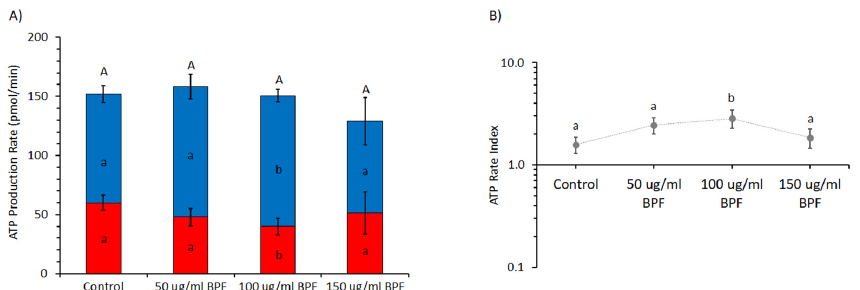
Figure 4. Effect of the BPF on the real-time ATP production rate in pAECs. ( A ) Evaluation of ATP production rate by mitochondrial OXPHOS (blue) ( █ ) or by glycolysis (red) ( █ ) in BPF-treated cells. ( B ) The ATP rate index, calculated as the ratio between the mitochondrial ATP production rate and the glycolytic ATP production rate, is shown on the y -axis (logarithmic scale) in pEACs treated without (control) and with the BPF. Data expressed as column charts (( A ) plots) and points (( B ) plots) represent the mean ± SD (vertical bars) from three experiments carried out on distinct cell preparations. Different lower-case letters indicate significantly different values ( p ≤ 0.05) among BPF treatments (0, 50, 100, and 150 µ g/mL) in the same metabolic pathway (OXPHOS or glycolysis) ( A ) and ratio value ( B ); different upper-case letters indicate different values ( p ≤ 0.05) among treatments in ATP production rates due to sum of OXPHOS plus glycolysis ( A ).